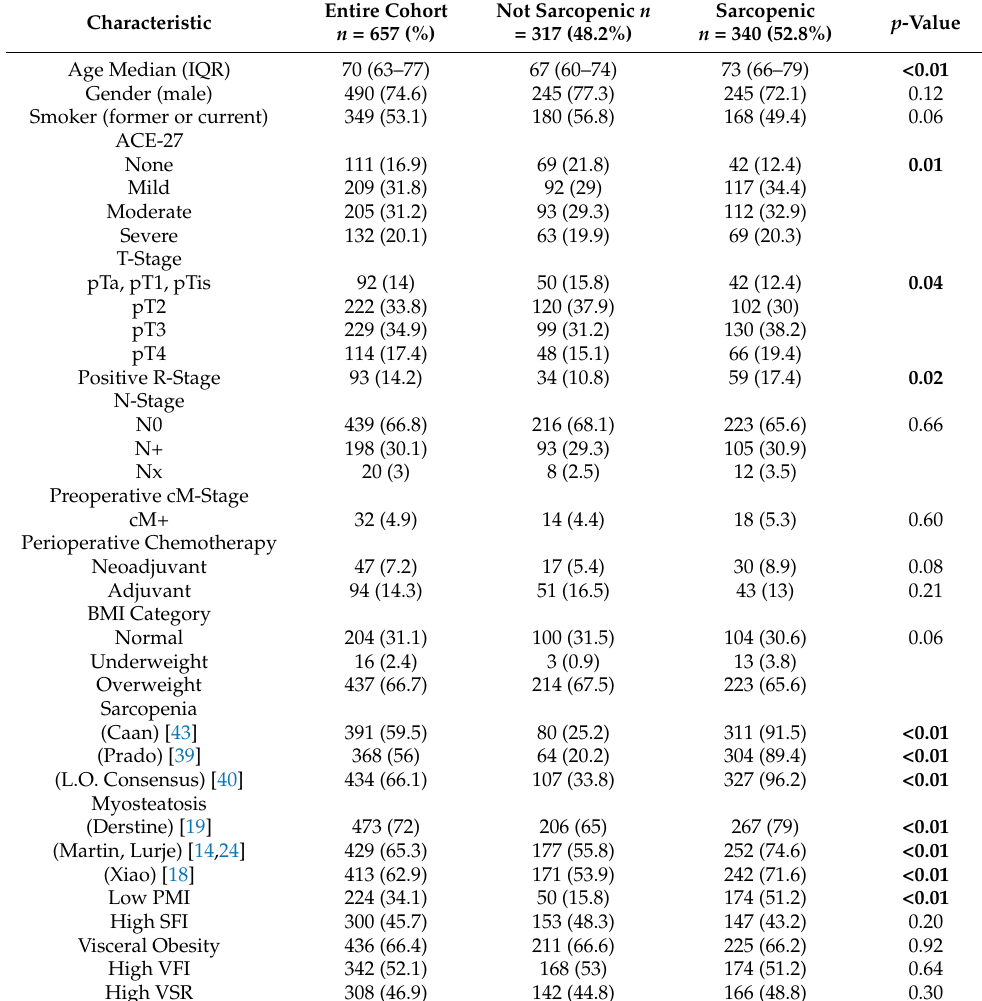
Table 2. Clinicopathologic parameters in the entire radical cystectomy cohort and relationship between sarcopenia (Martin) and clinicopathologic and body composition